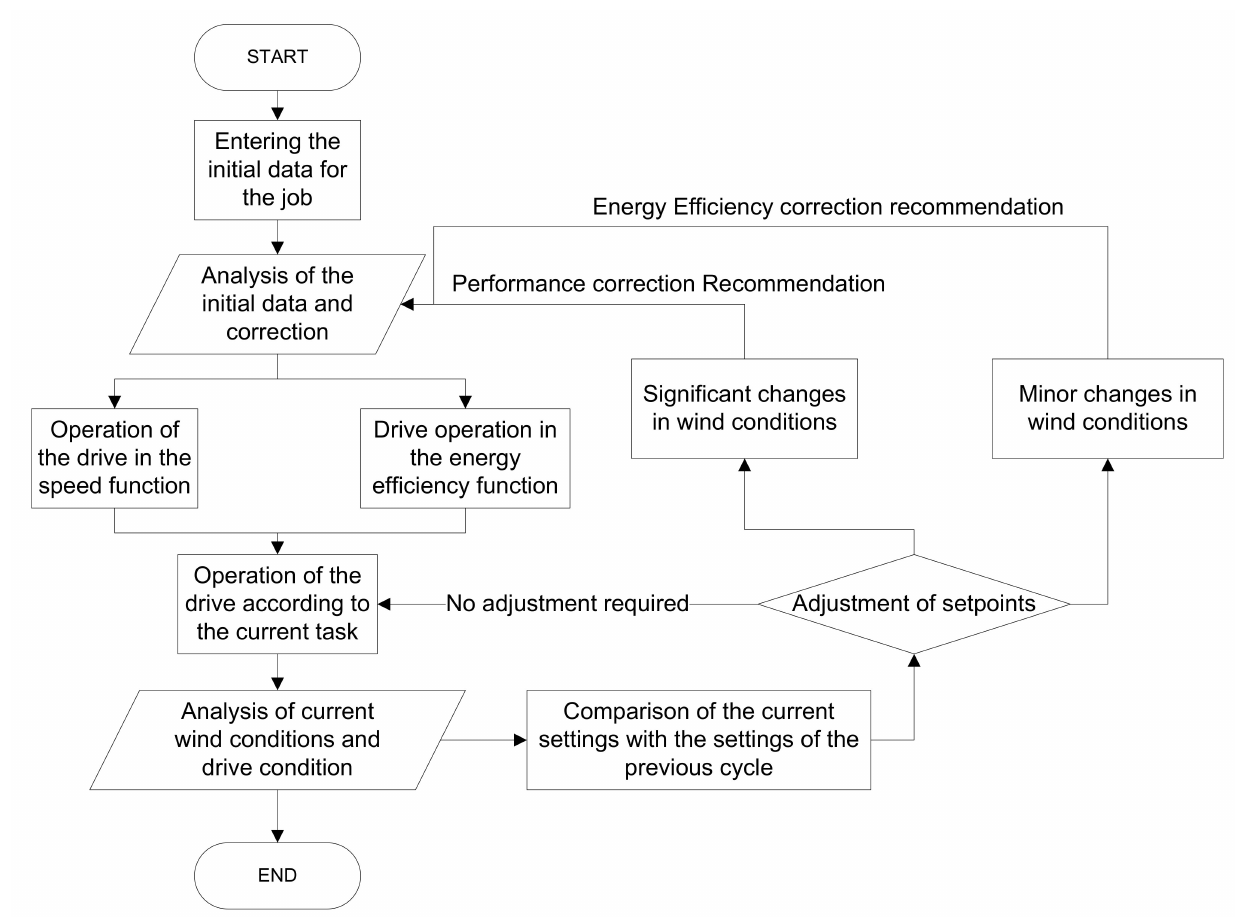
Figure 7. Algorithm for optimal operation of the